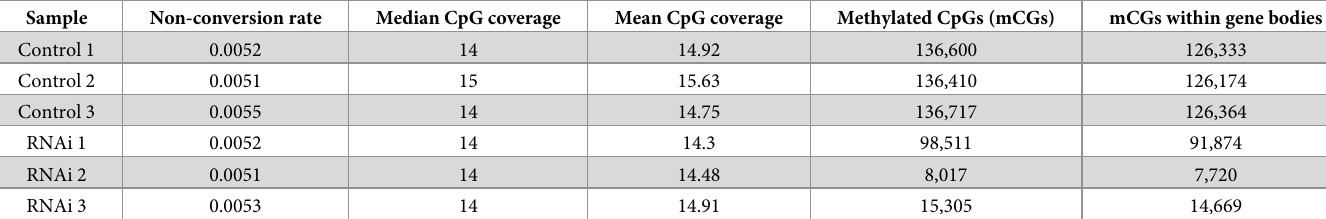
Table 1. Summary CpG statistics and non-conversion rates for each sample.